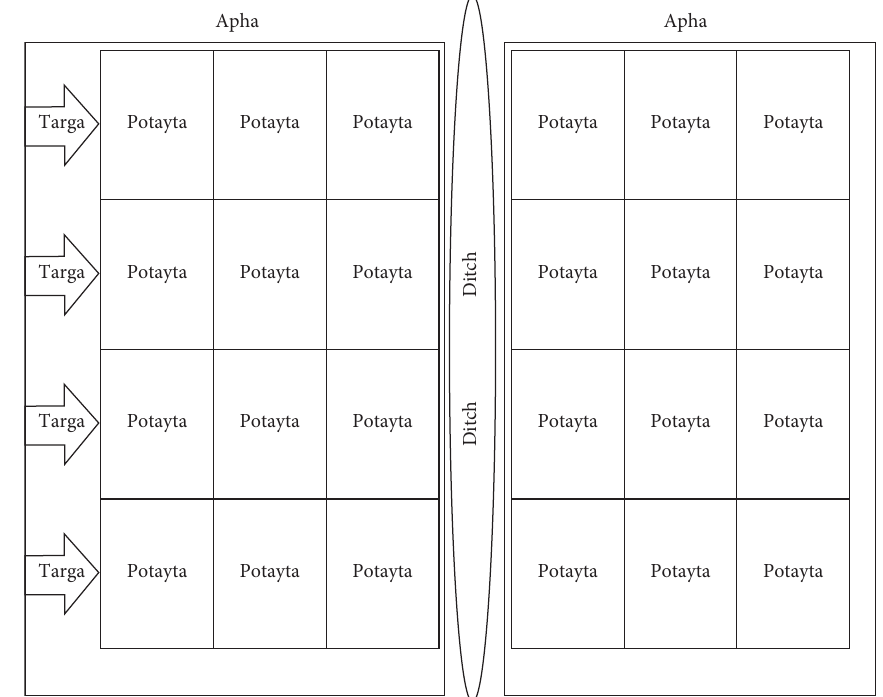
Figure 4: Schematic representation of Apha constituting Targa-na-Potayta , an indigenous mulching technique in Derashe